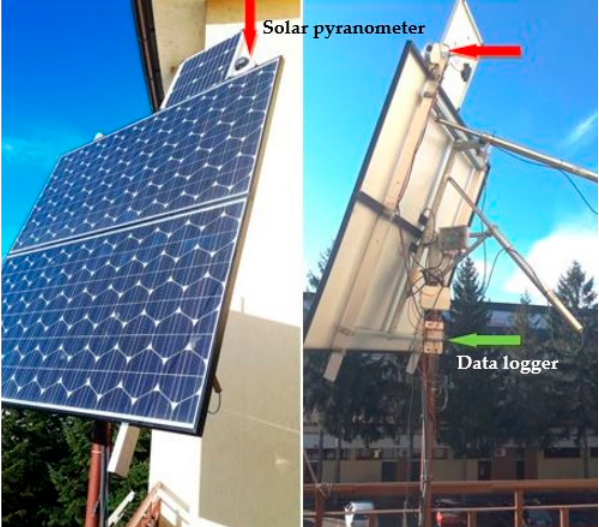
Figure 3. PV panels with an integrated tracking system. Position of the solar irradiance monitoring system (SPN1) and data logger module (GP1).